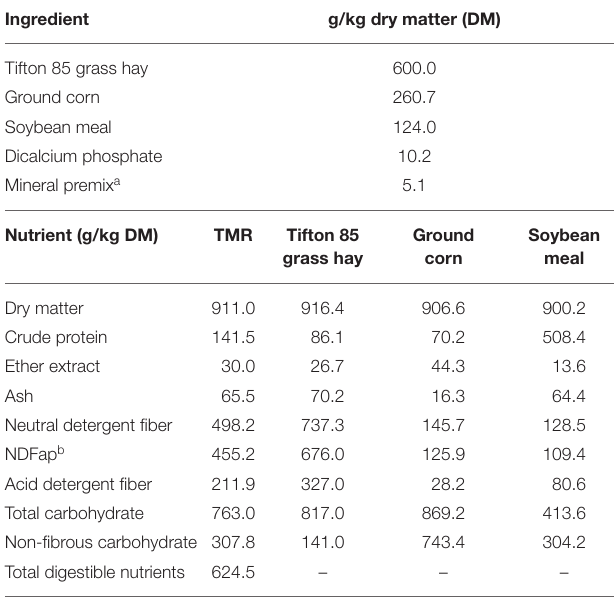
TABLE 1 | Ingredient proportions and chemical composition of total mix ration